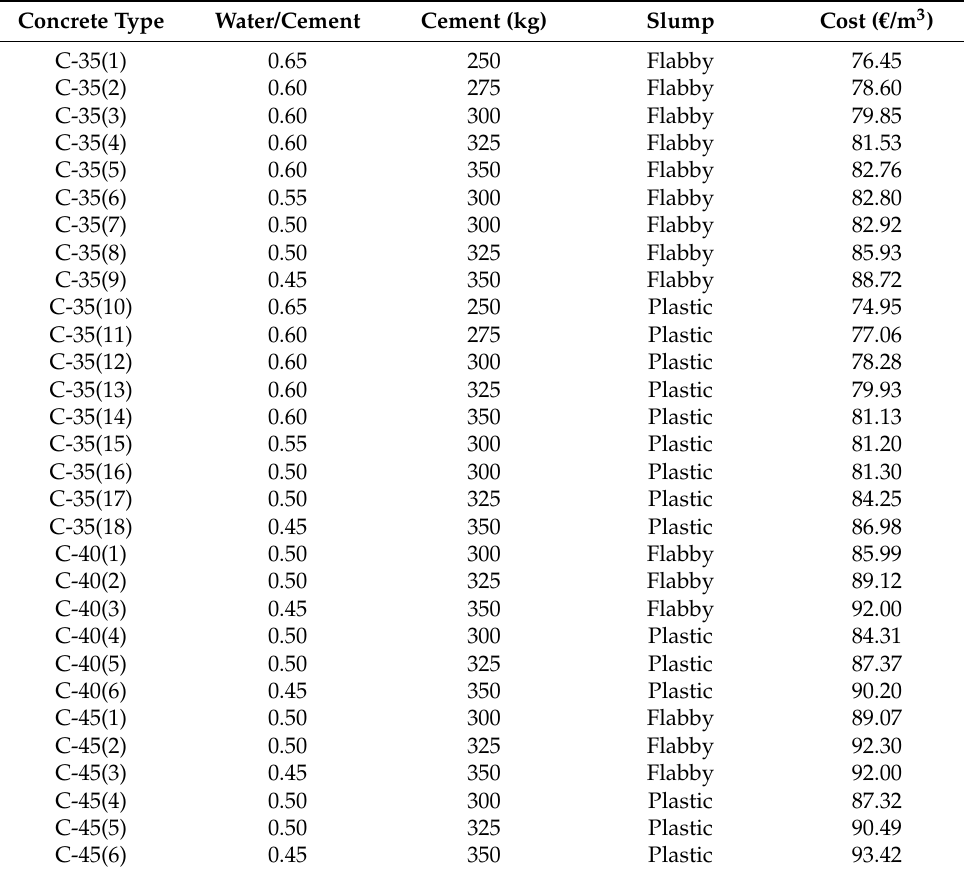
Table 4. Concrete unit costs for C-35, C-40 and